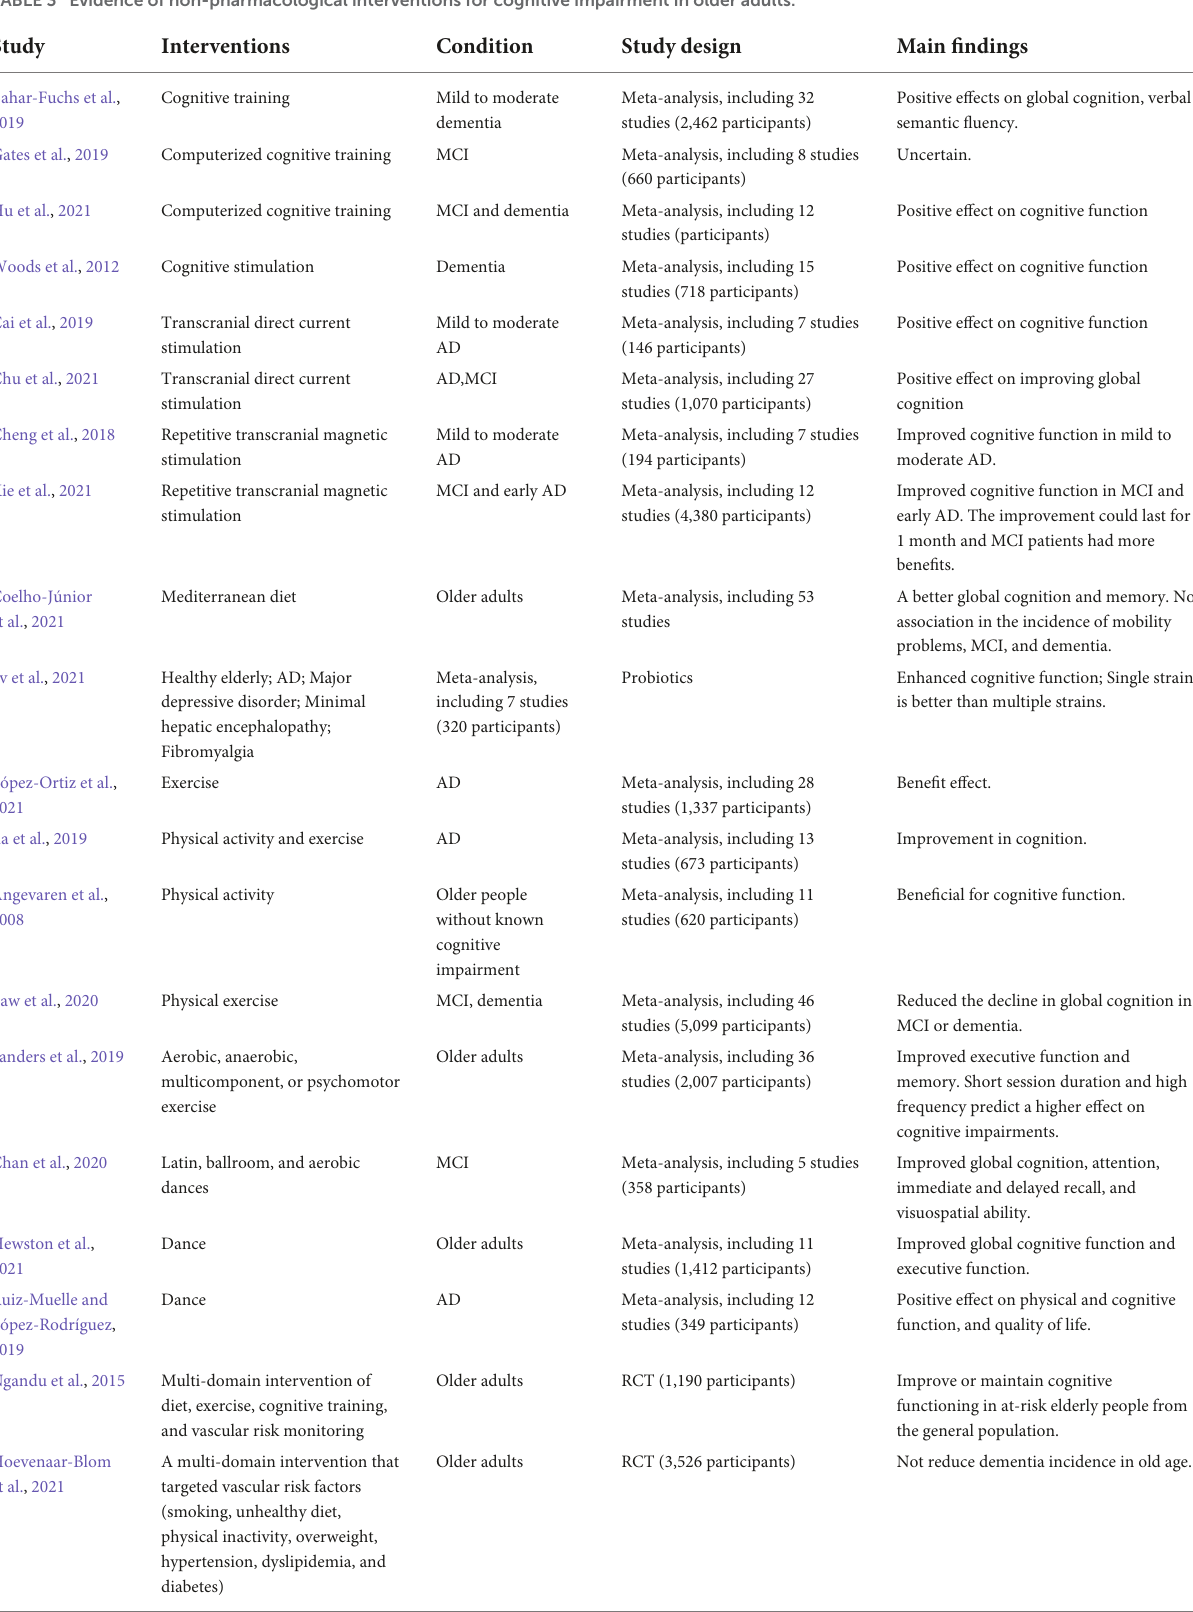
TABLE 3 Evidence of non-pharmacological interventions for cognitive impairment in older